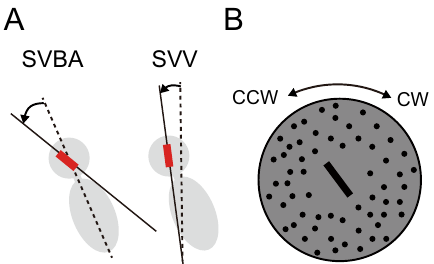
Figure 4. Schematic illustration of each spatial orientation task and visual stimuli. ( A ) Participants were asked to align the visual line (denoted as red lines) along the perceived direction of the body longitudinal axis (SVBA task) or gravitational vertical (SVV task). Adjustment errors in each task (denoted as arrows) were calculated as the angular bias of the subjective directions of body longitudinal axis or vertical (solid lines) from the objective directions (dotted lines). ( B ) Illustration of the visual stimuli on the display as seen by the participants in the optokinetic stimulation (OKS) conditions. Many dots were randomly positioned around the visual line, and they rotated uniformly clockwise (CW) or counterclockwise (CCW) around the center of the display during the SVBA or SVV